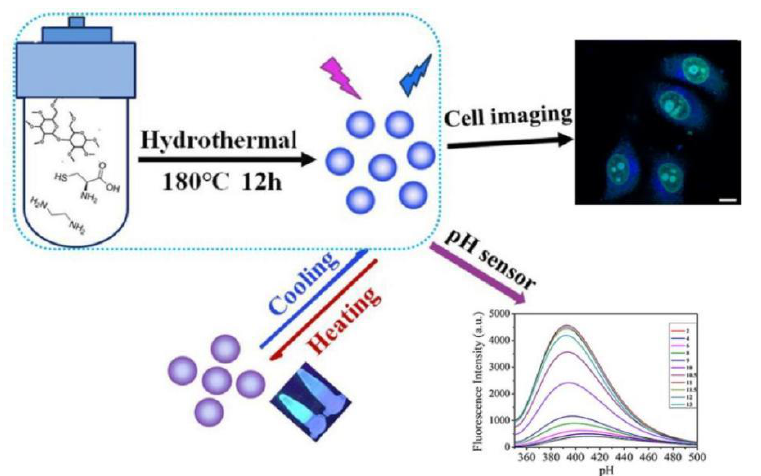
Figure 11. Schematic illustration of the synthetic procedure of N, S-CDs and multifunctional applications of pH detection, temperature monitoring, RNA-selective imaging. Adapted with permission fromLiu et al., 2021, copyright 2021. Reproduced with permission from Elsevier [78].